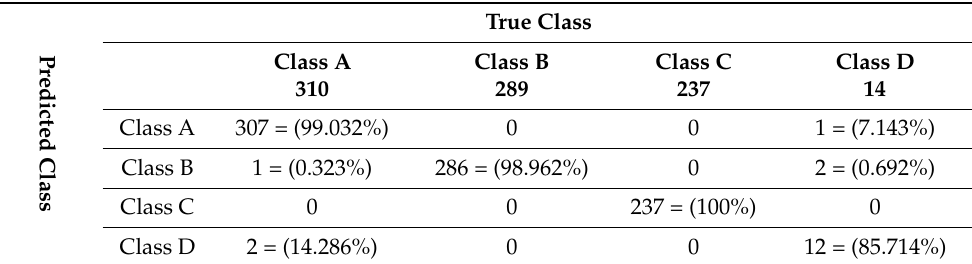
Table 8. The obtained confusion matrix of the third